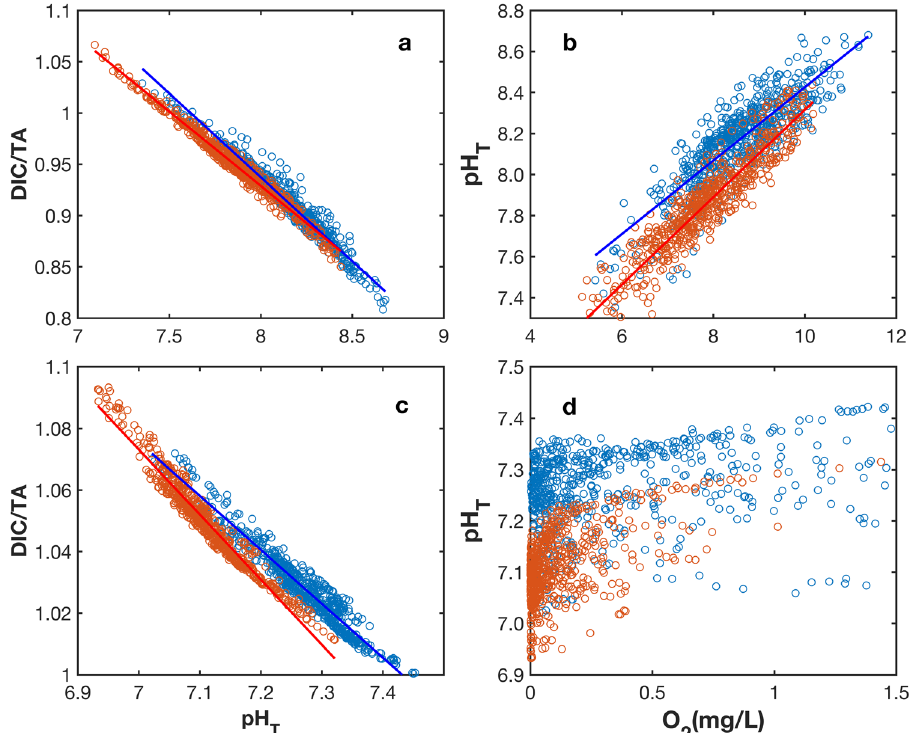
Fig. 3 Connection between acidi fi cation and hypoxia. Changes in DIC/TA - pH T ( a , c ) and pH T - O 2 ( b , d ) relationships in the surface ( a , b )/bottom ( c , d ) water at CB4.3: the late 20th (blue) and mid-21st century